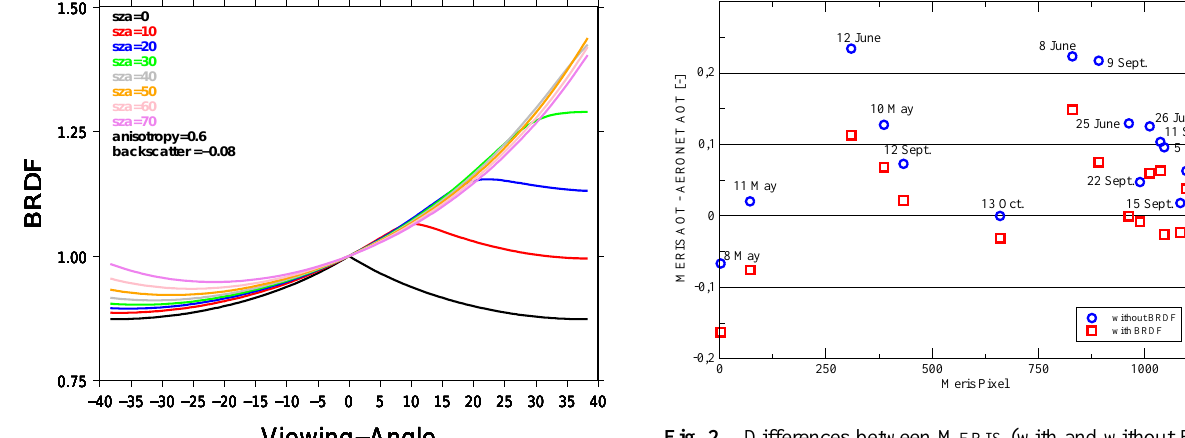
Fig. 2. Differences between M ERIS (with and without B RDF ef- Fig. A2. Differences between M ERIS (with and without B RDF fects) and A ERONET A OD at 440nm over Hamburg for sixteen col- effects) and A ERONET A OD at 440nm over Hamburg for sixteen located measurements at cloud free days in 2006. collocated measurements at cloud free days in 2006.